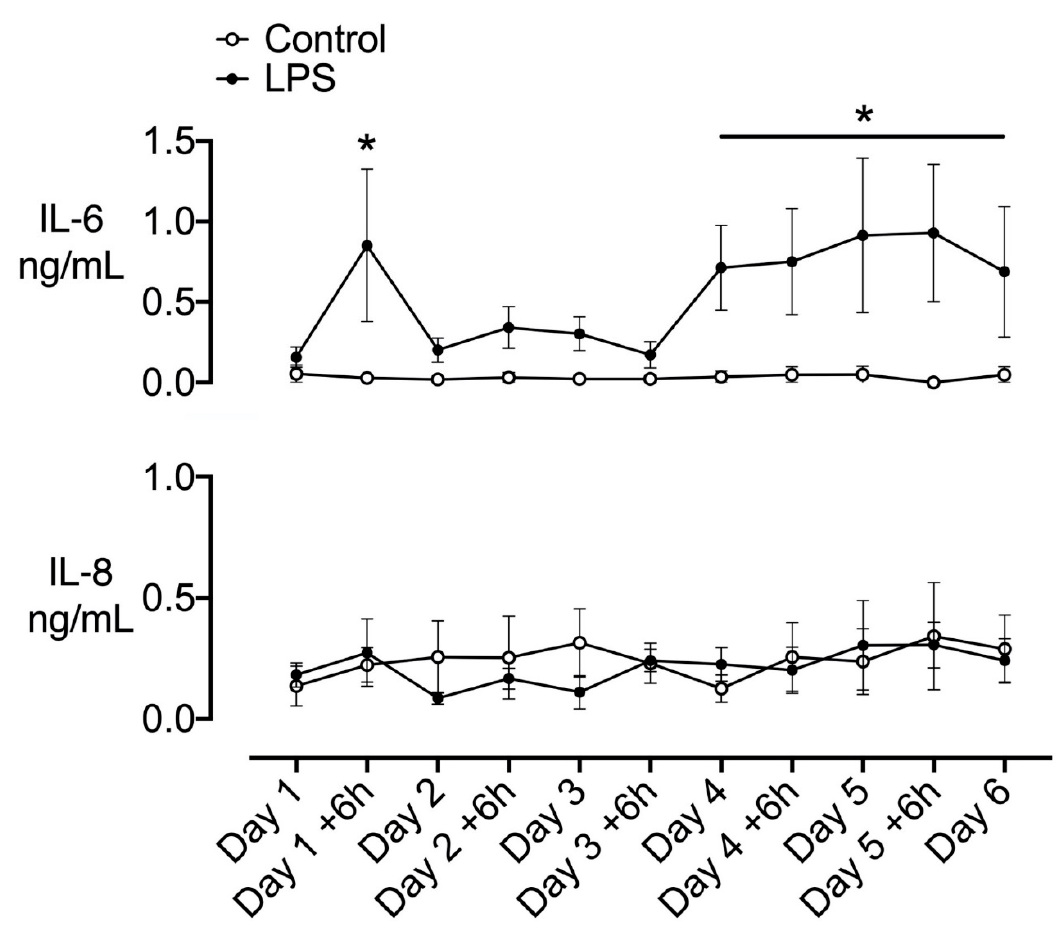
Figure 1. Time-course of changes in circulating interleukins. Time-course of changes in circulating interleukin (IL)-6 and IL-8 in the control (open circles, n = 6) and lipopolysaccharide (LPS) (closed circles, n = 7) groups. The dark shaded area represents the period of increasing LPS infusion. Data are hourly means ± SEM. * p < 0.05, LPS vs. control.